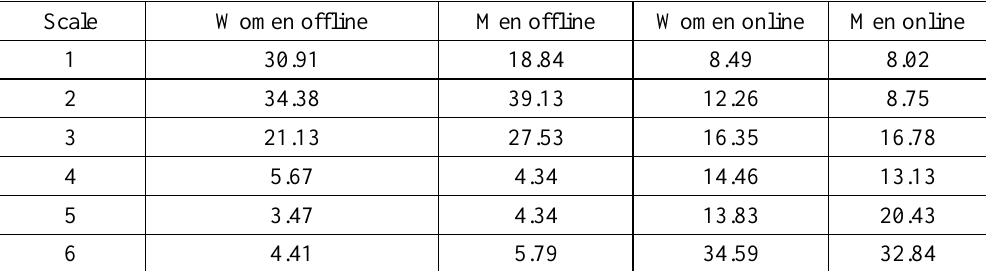
Table 2. Distribution of Evaluations of Online and Offline Networks by Gender